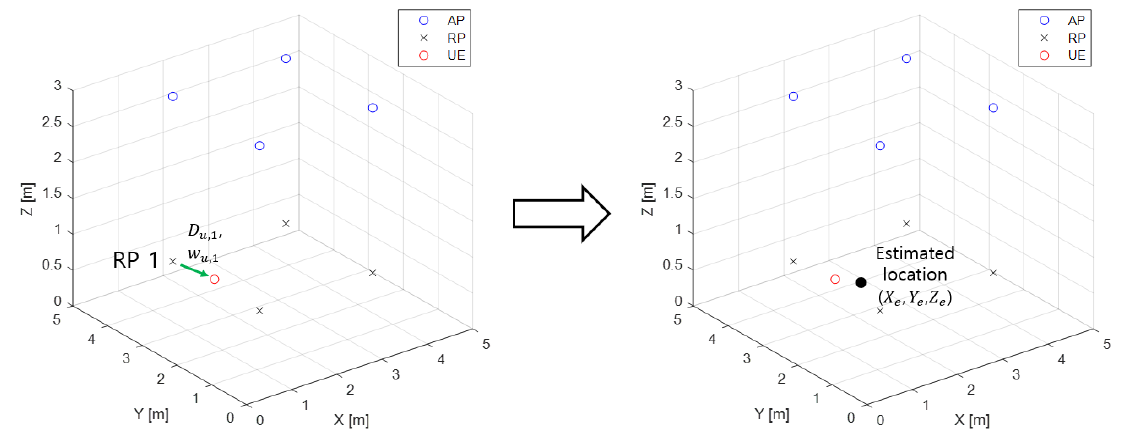
Figure 7. Processing step of WkNN.